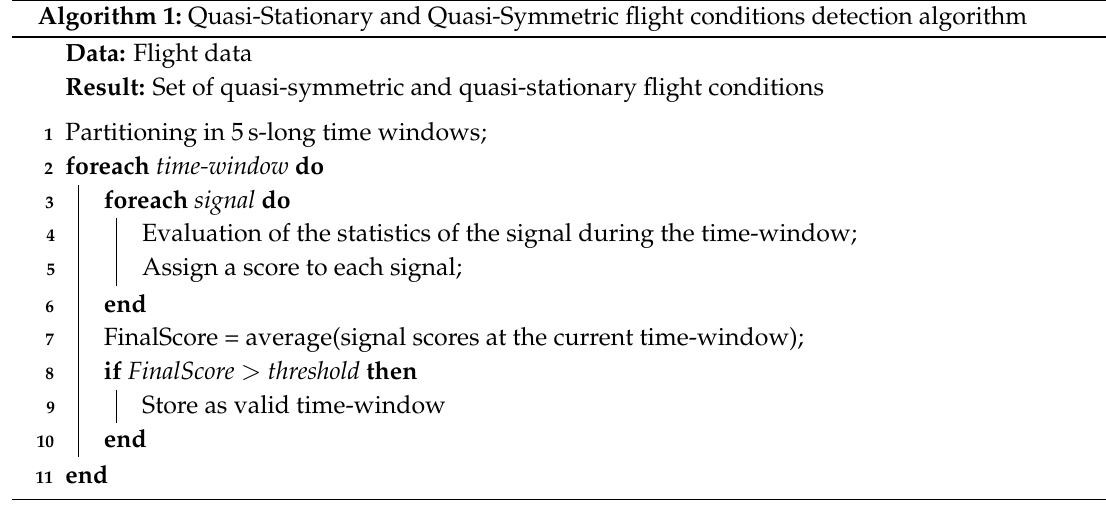
Algorithm 1: Quasi-Stationary and Quasi-Symmetric flight conditions detection algorithm Data: Flight